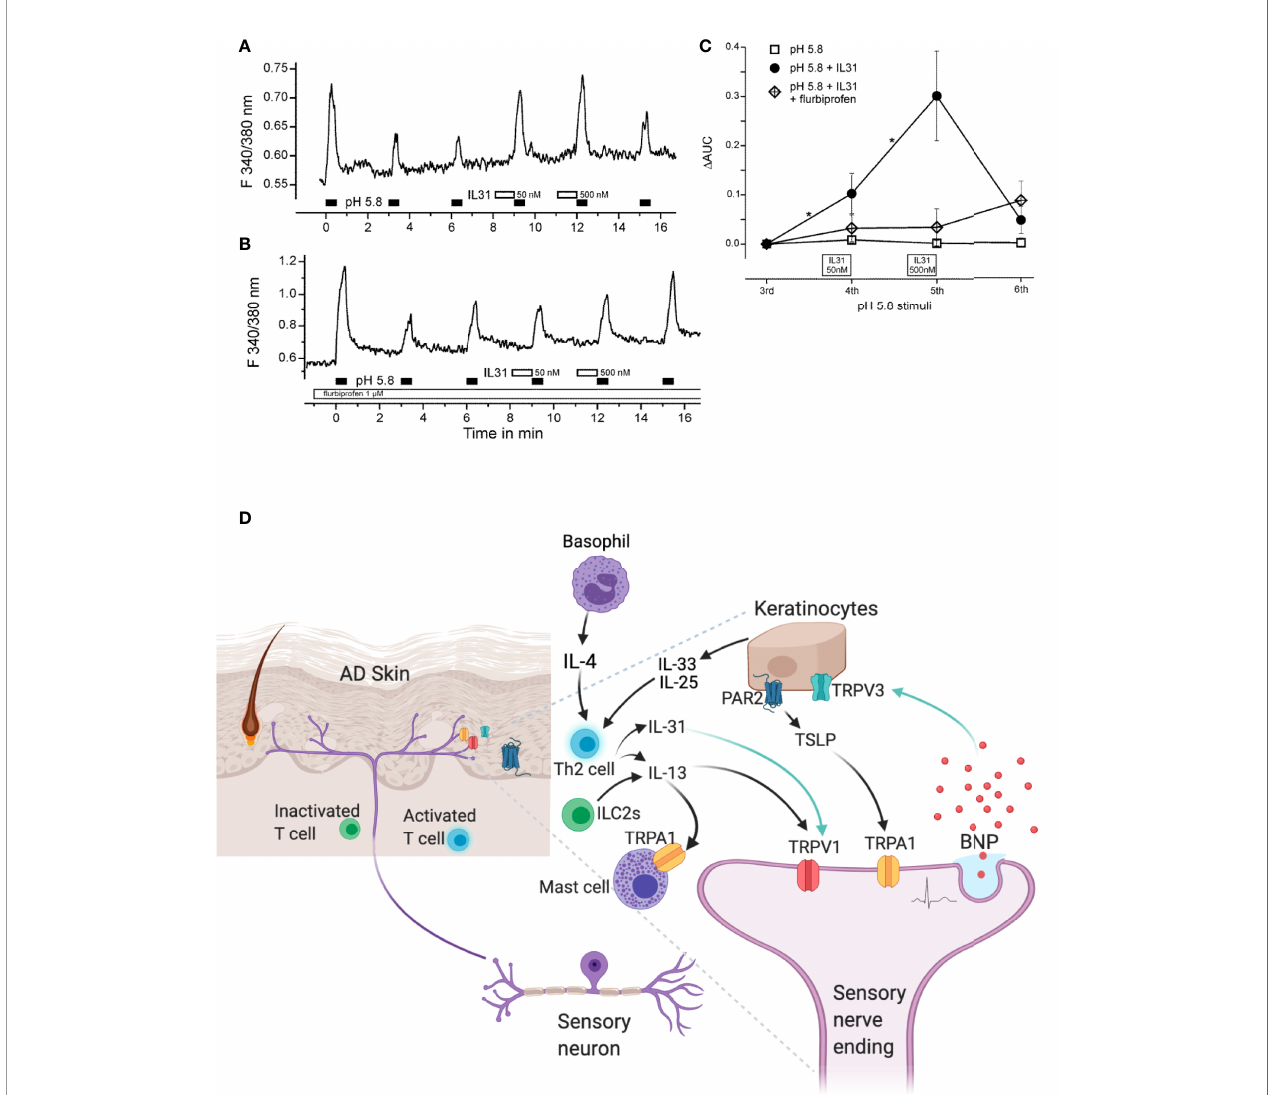
FIGURE 1 | Th2-cytokine induced potentiation and sensitization of TRP channels in sensory neurons and skin. IL-31 potentiates TRPV1 in cultured murine DRG neurons. Calcium spikes on mDRG neurons excited with 200 ms exposure time at 1 Hz when continuously superfused with extracellular solution (145 mM NaCl, 1.25 mM CaCl2, 1 mM MgCl 2 , 5 mM KCl, 10 mM glucose, and 10 mM HEPES; adjusted to pH 7.3). IL-31 was diluted in this solution. Experimental procedures had been approved by the Medical University of Vienna Ethics Committee and local Authorities. (A) TRPV1 was repetitively stimulated by pH 5.8 solution. A 60 s pre- application of IL-31 dose-dependently potentiated acid-induced activation of TRPV1 based on AUC; (B) Abolishment of this sensitization in the presence of Cox1/2 blocker, fl urbiprofen at 1 µM. (C) Quantitative analysis of panels (A, B) ; changes in the AUC ( D AUC) are presented relative to the third stimulation of (A, B) ; n = 26, p = 0.009 vs . IL-31, ANOVA, post-hoc HSD; *P < 0.05. (D) IL-31 and IL-13, and PAR2-TSLP activation potentiate sensory neuronal TRPV1 and TRPA1 through fast and slow mechanism. In detail, disease-driven IL-31 upregulates TRPV1 synthesis and rapidly sensitizes TRPV1 channel function in sensory neurons. IL-13 enhances TRPA1 synthesis in mast cells. TSLP upregulates TRPA1 synthesis in sensory neurons. IL-31 induced BNP release from sensory neurons can increase the transcription level of TRPV3 in keratinocytes and elevate its activity. The Th2-cytokine mediated potentiation worsens pruritic and in fl ammatory conditions, resulting severe impairment of the skin barrier, increased susceptibility to infections, and elevated allergen sensitization in